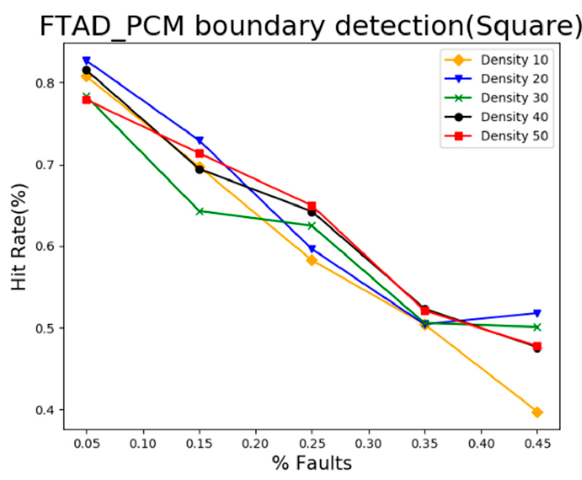
Figure 8. FTAD_PCM boundary detection (square). Information 2018 , 9 , x FOR PEER REVIEW